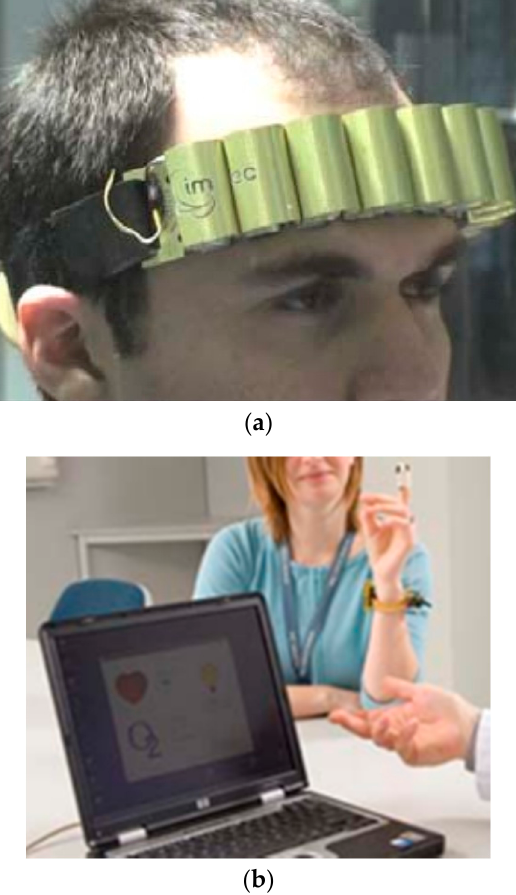
Figure 11. ( a ) TEG supplies power to an EEG system mounted on an expandable headband [133]; ( b ) Wireless pulse oximeter [134].